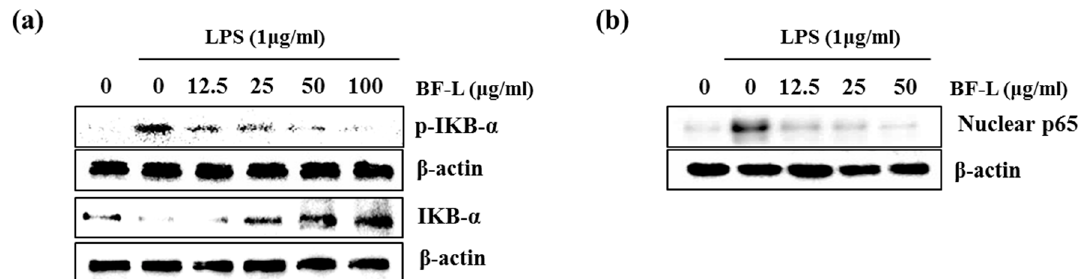
Figure 3. Effect of BF-L on NF- κ B signaling activation in LPS-stimulated RAW264.7 cells. ( a ) RAW264.7 cells were pretreated with BF-L for 6 h and then co-treated with LPS (1 µ g/mL) for 30 min. For Western blot analysis, the cell lysates were subjected to SDS-PAGE and the Western blot was performed using antibodies against p-I κ B- α and I κ B- α . β -actin was used as internal control. ( b ) RAW264.7 cells were pretreated with BR-L for 6 h and then co-treated with LPS (1 µ g/mL) for 30 min. After the treatment, the nucleus fraction was prepared. For Western blot analysis, the cell lysates were subjected to SDS-PAGE and the Western blot was performed using antibodies against p65. Actin was used as internal control for Western blot analysis.